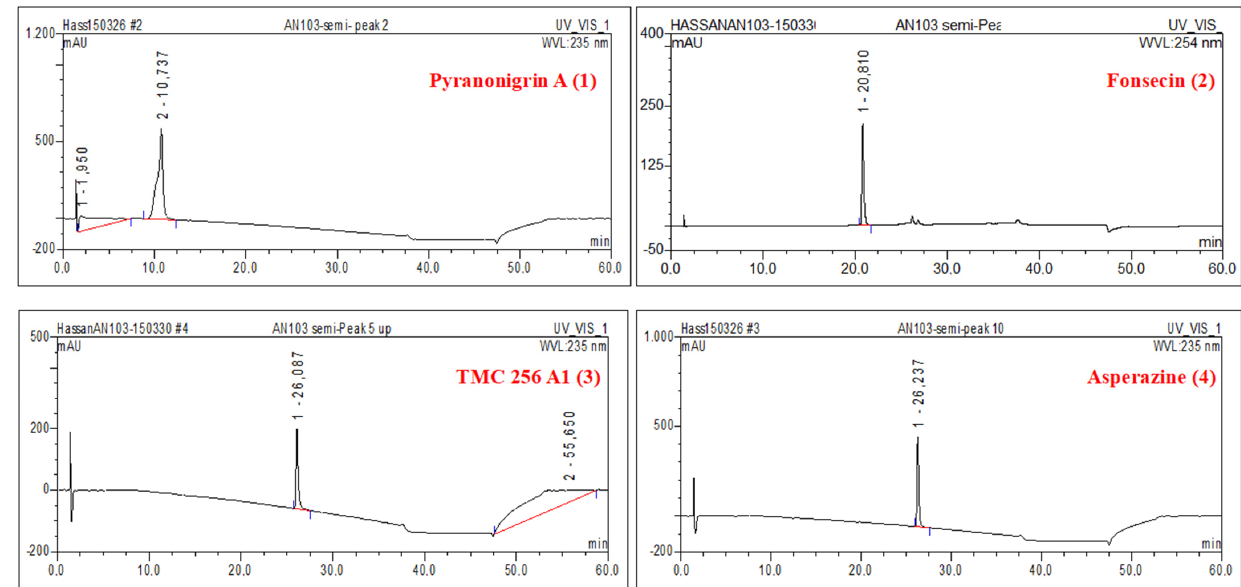
Figure 3. HPLC chromatograms of the isolated pure compounds (1 – 4), from EtOAc extract active fraction of A. tubingensis NA103.